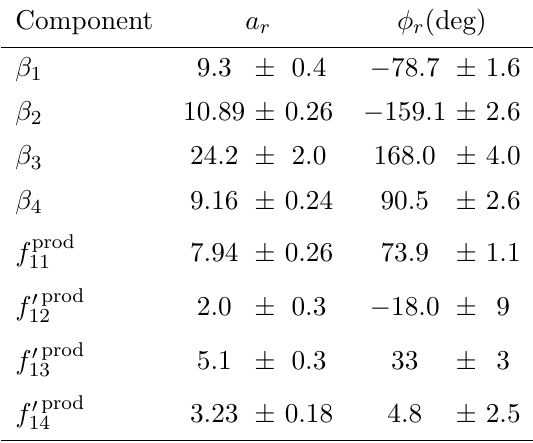
π + π − Dalitz plot distribution S . /f prod 1 v 11